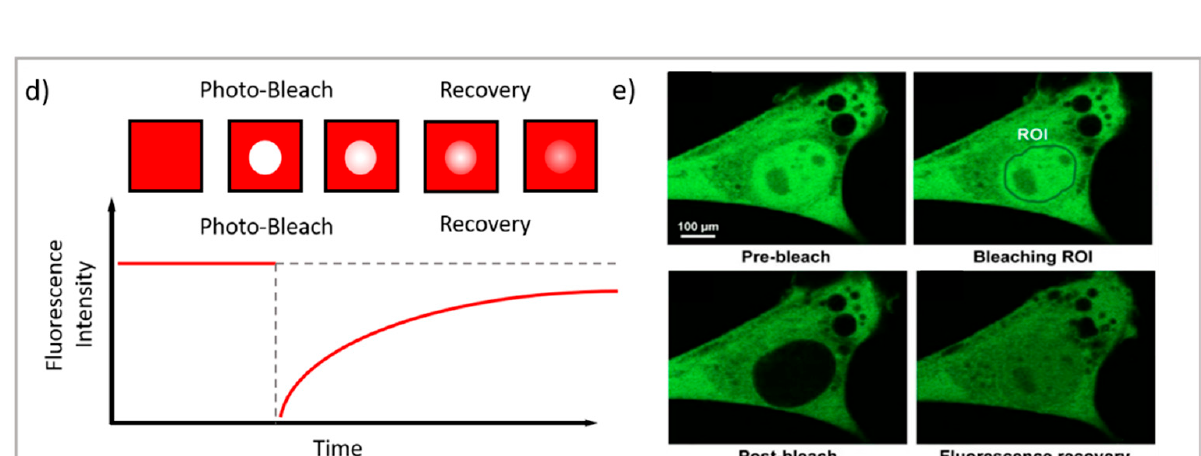
Figure 3. ( a ) PT technique: diffusion of NPs in the cytosol studied using single-particle fluorescence tracking and three schematic illustrations of intracellular diffusion—free, restricted, and a combination of free and restricted diffusion (adapted with permission from [67]; copyright (2018) WILEY-VCH Verlag GmbH & Co. KGaA, Weinheim, Germany). ( b , c ) FCS technique: (b) examples of FCS curves measured in different cellular compartments reprinted from [16] (copyright (2019), with permission from Elsevier), ( c ) a schematic illustration of FCS set-up reprinted from [68] (copyright (2012), with permission from Elsevier). ( d , e ) FRAP technique: ( d ) basic representation of the FRAP approach [69], ( e ) example of a FRAP experiment on a myoblast cell line (myo3), before and after bleaching [70].